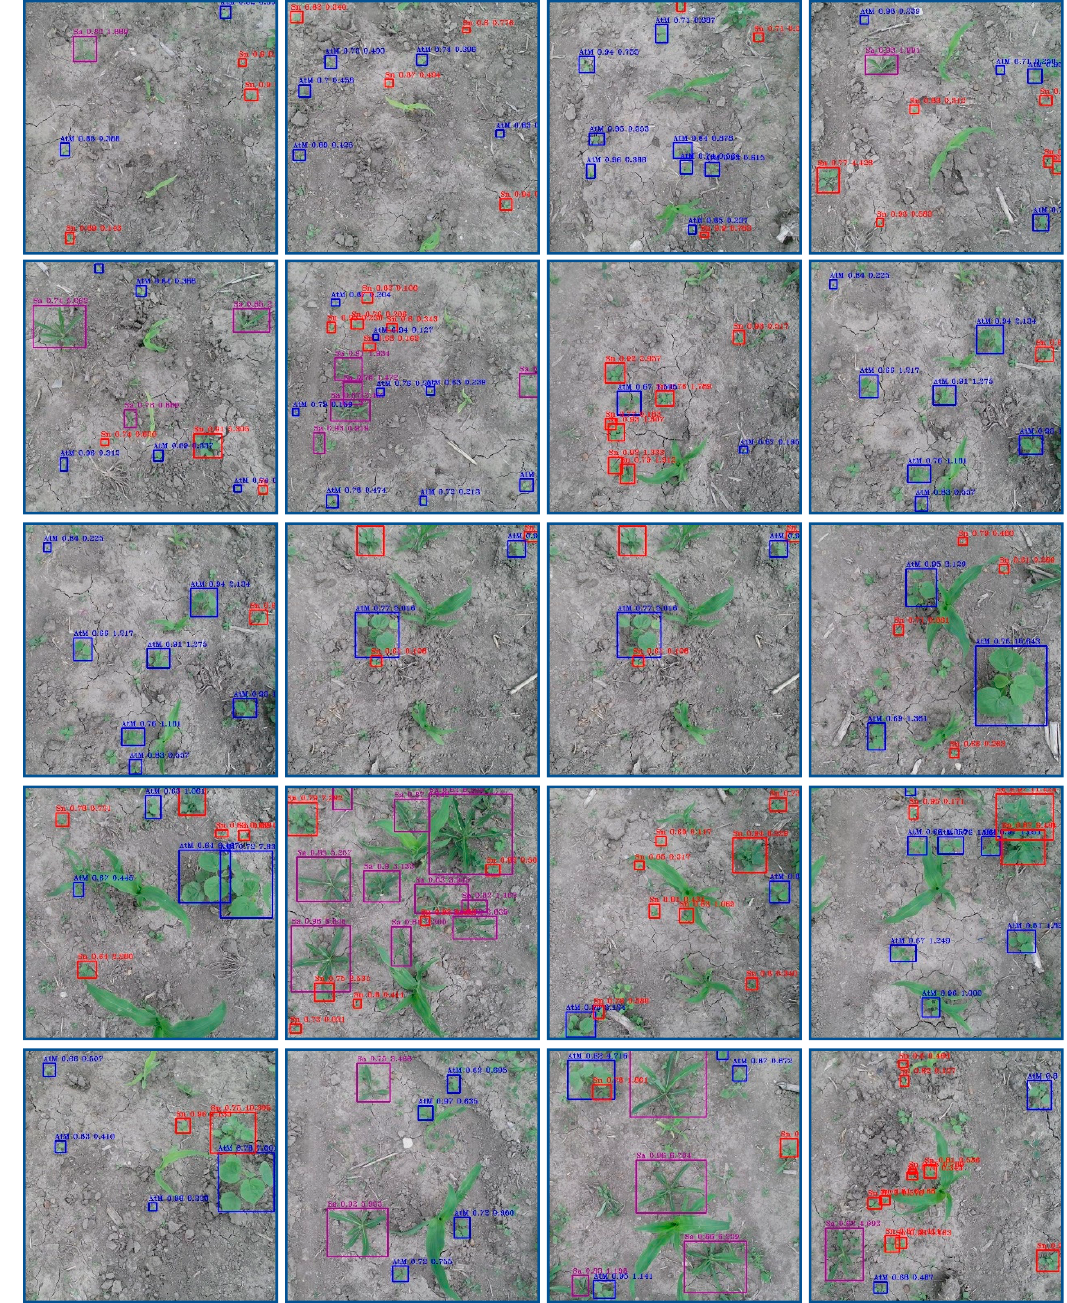
Figure A3. Visualization of the results of two-stream dense feature fusion network on RGB images. Notes: Labels in order of species, confidence, aboveground fresh weight.